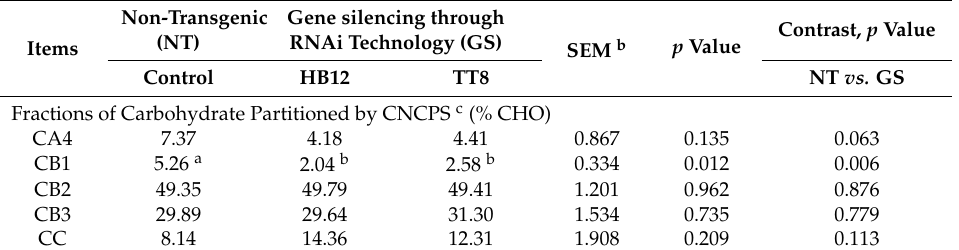
Table 2. Effect of HB12 and TT8 down-regulation on carbohydrate subfractions in model